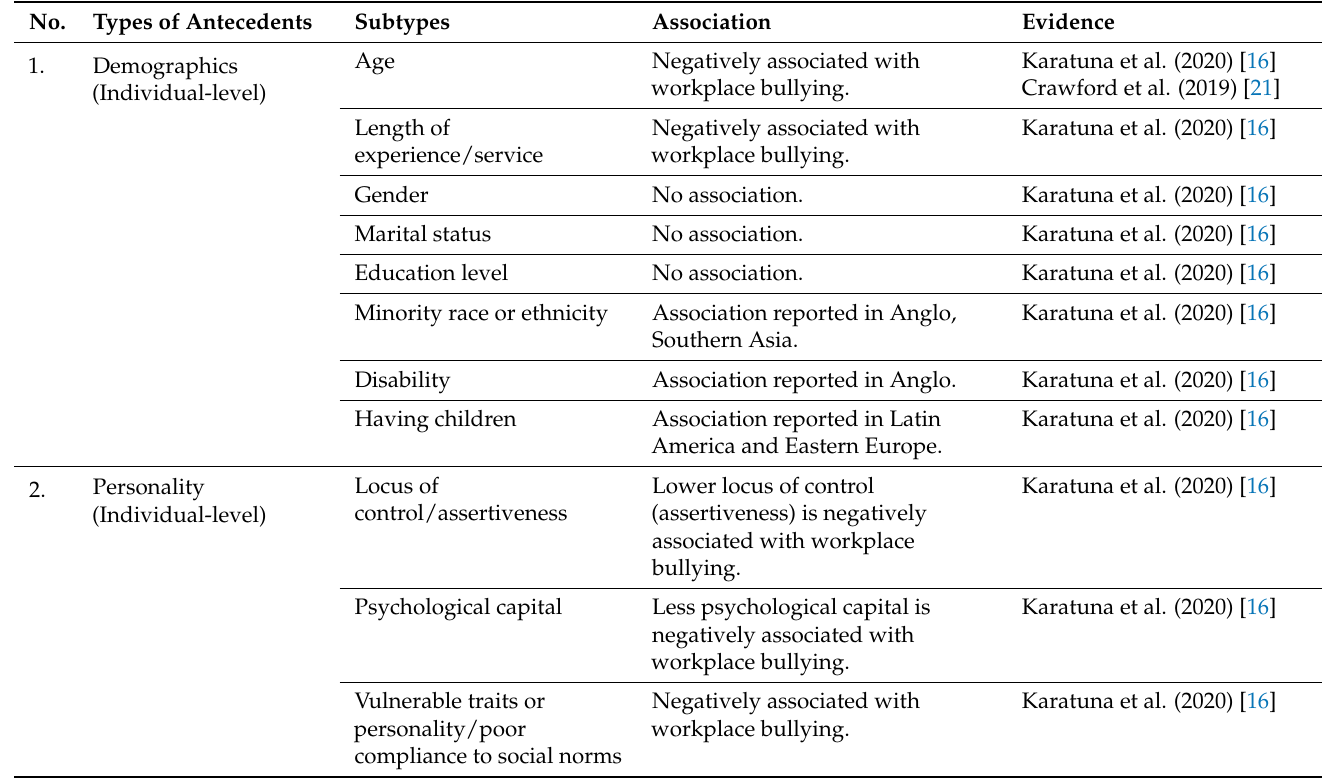
Table 4. Summary table of antecedents for workplace